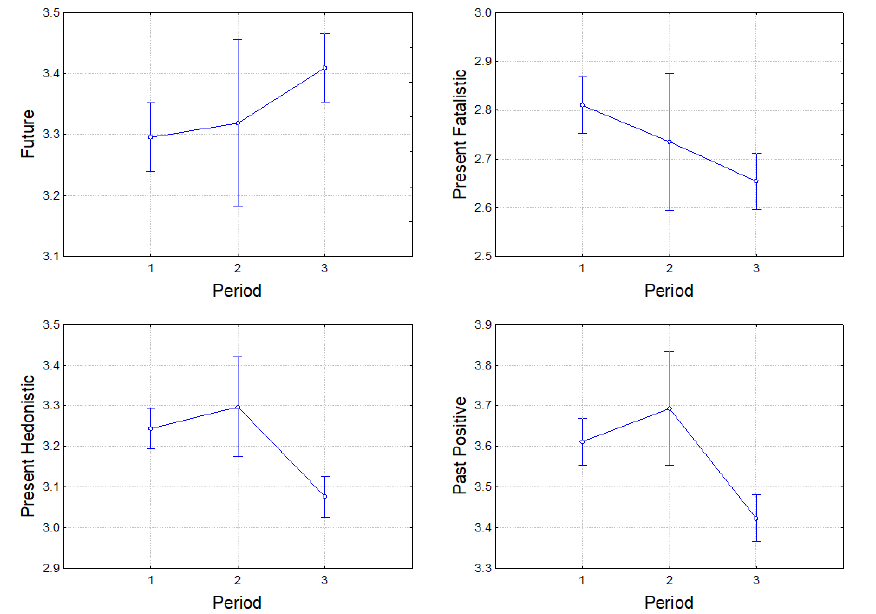
Figure 1. Graphs of significant differences in the future , present fatalistic , present-hedonistic , and past-positive time orientations observed from pre-crisis to crisis periods in the Lviv region. Axis “period”: 1—pre-crisis subgroup 1 (June 2010–March 2011), 2—pre-crisis subgroup 2 (December 2012–October 2013), 3—crisis group (March 2015–April 2016).